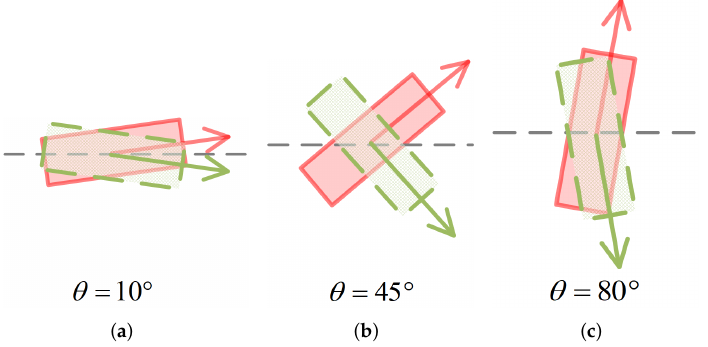
Figure 8. The influence of axis prediction error on IoU at different values of θ . We show the cases when θ = 10 ◦ ( a ), θ = 45 ◦ ( b ) and θ = 80 ◦ ( c ). We use red solid box to denote the ground truth box and green-dotted box to denote the predicted box.